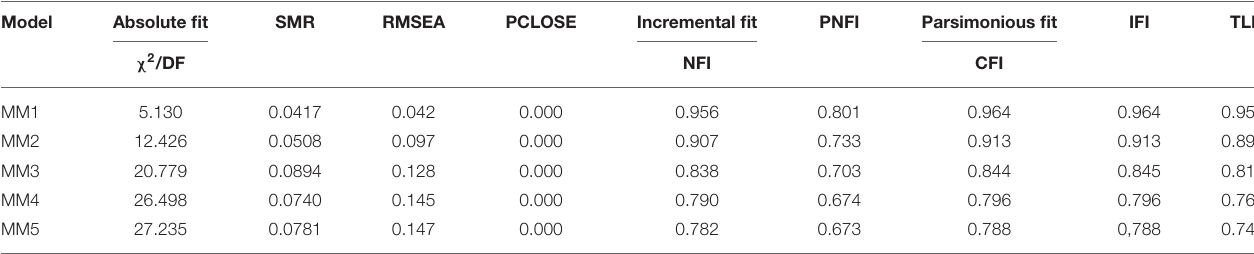
TABLE 4 | Measurement and structural model comparison.